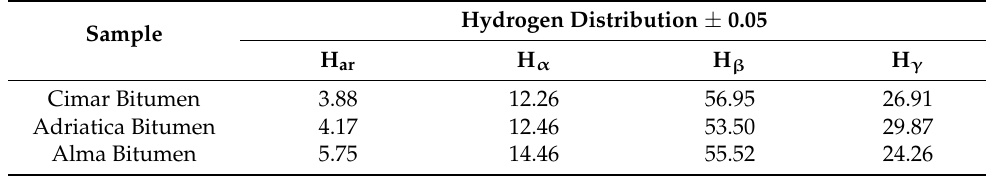
Figure 2. 1 H-NMR spectra of Cimar bitumen ( a ), Adriatica bitumen ( b ) and Alma bitumen ( c ). Table 4. Fractional proton distribution of Cimar, Adriatica and Alma